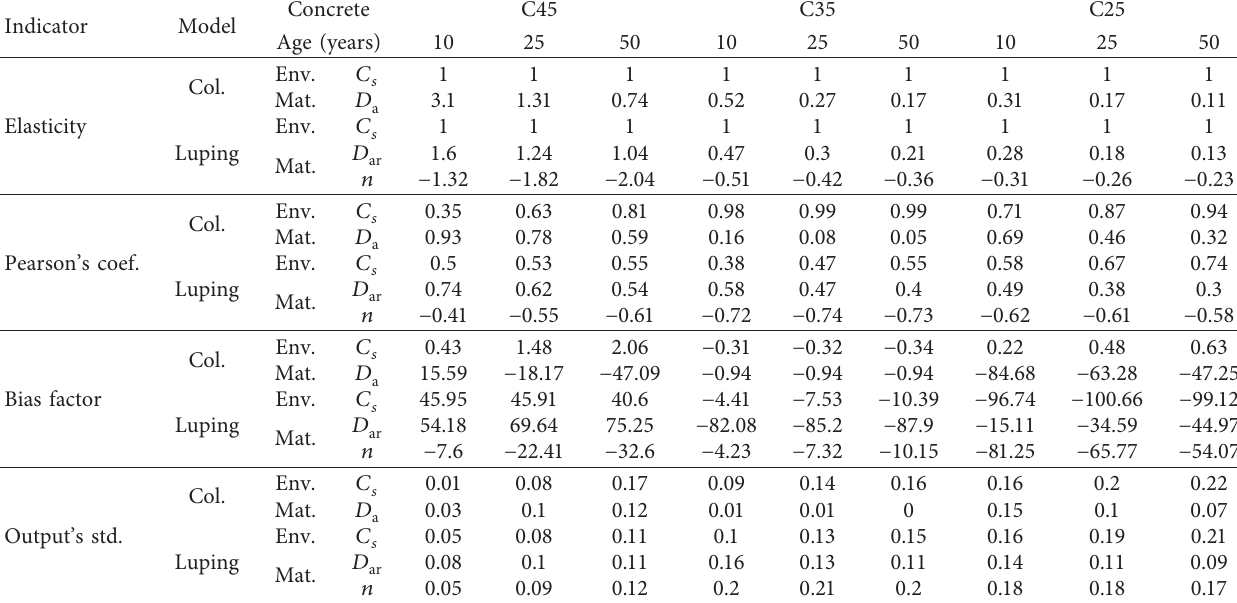
Table 10: Results of sensitivity analysis for two models of chlorination (Collepardi (Col.) and Luping) at 2.5cm [17]. Concrete Indicator Model Env. Col. Mat. Env. Elasticity Luping